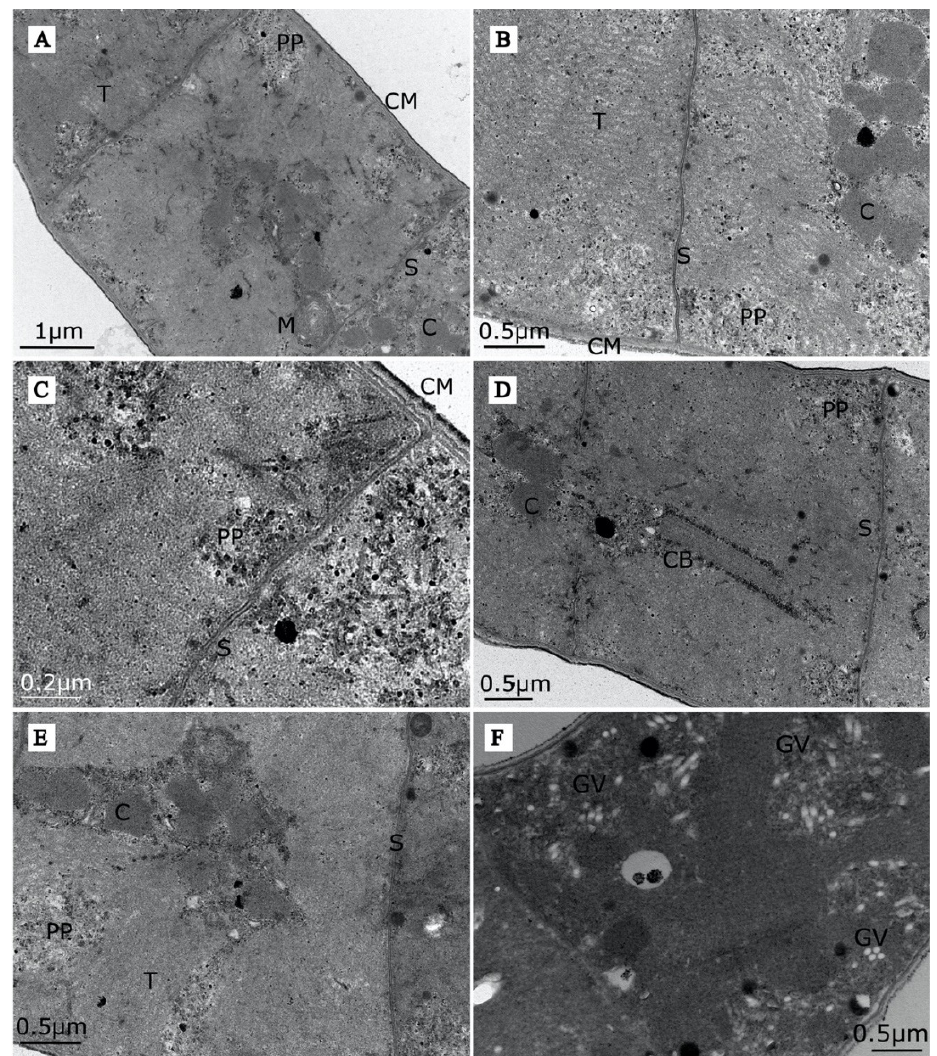
Figure 2. TEM photography of cellular ultrastructures of Arthrospira sp. O9.13F. Panels ( A – F ) represent different cross-sections of cells illustrating ultrastructures recognised. Abbreviations as follows: cell membrane (CM), septum (S), gas vesicles (GV), thylakoids with bead-like ribosomes (T), mesosome (M), carboxysomes (C), cylindrical bodies (CB), polyphosphate granule (PP).